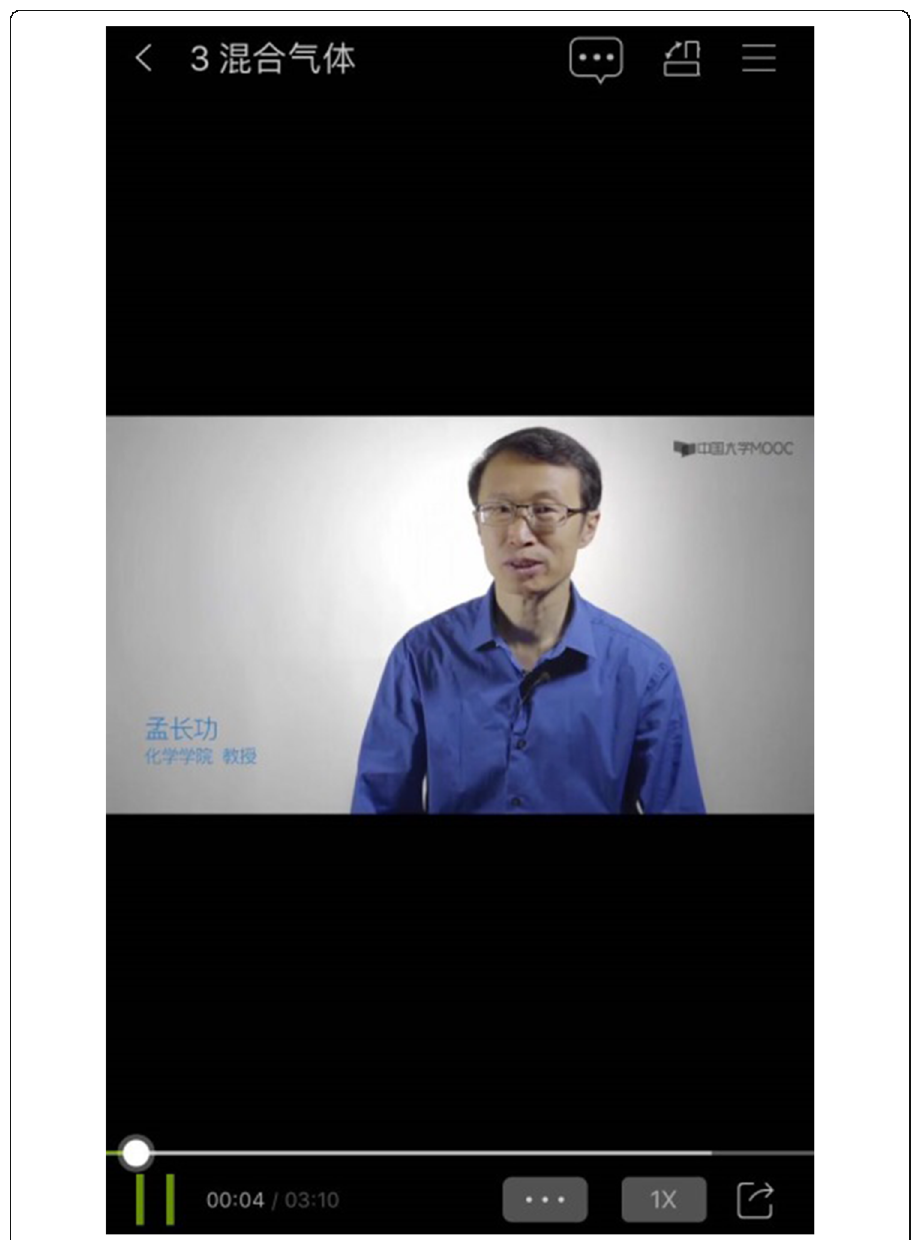
Fig. 1 An example of a micro-lecture with slides. The video screenshot of the chemistry course is taken from the Chinese university MOOC platform. Students can watch the video repeatedly by clicking the pause, forward and rewind buttons at the bottom, and also adjust the video playback